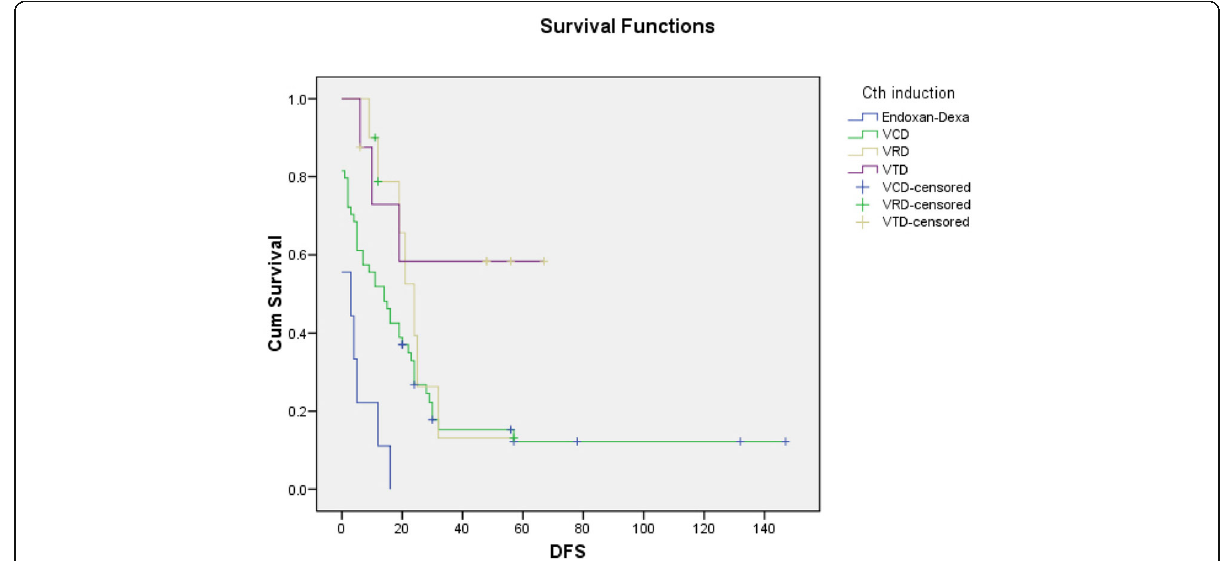
Fig. 2 Kaplan-Meier analysis for DFS between the different treatment regimens